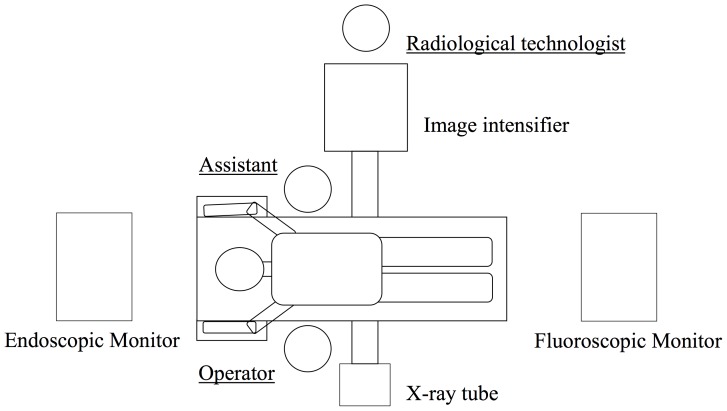
Intraoperative setup of the surgical team and equipment.A single C-arm was used for fluoroscopic imaging. The operating surgeon stood next to the X-ray tube. The assisting surgeon and radiological technologist were stationed at the opposite site, along with the image intensifier.